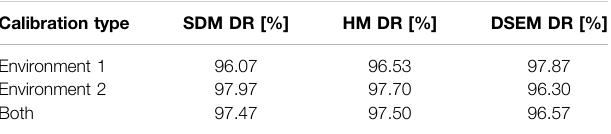
TABLE 8 | Testing phase. Mean value of DR for tests performed in Environment 2 versus calibration